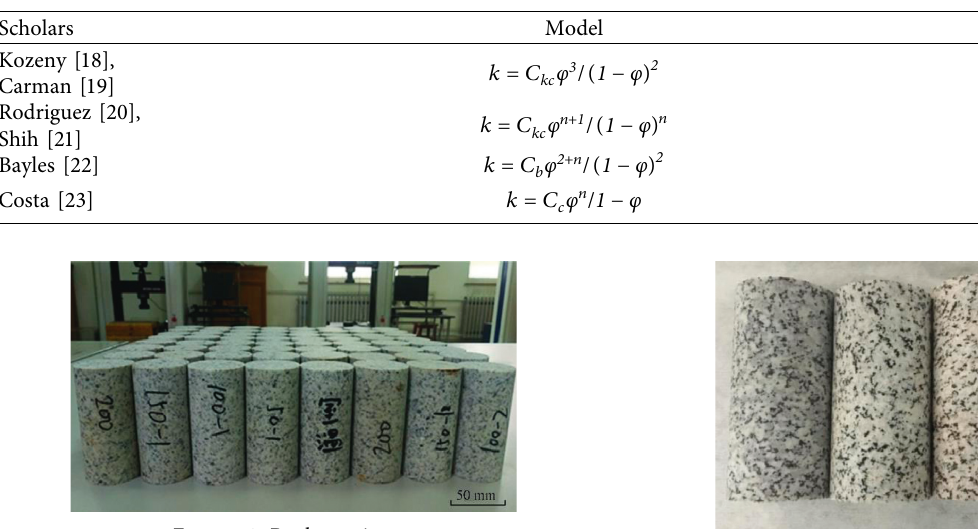
Table 1: K-C model and its main modified model.